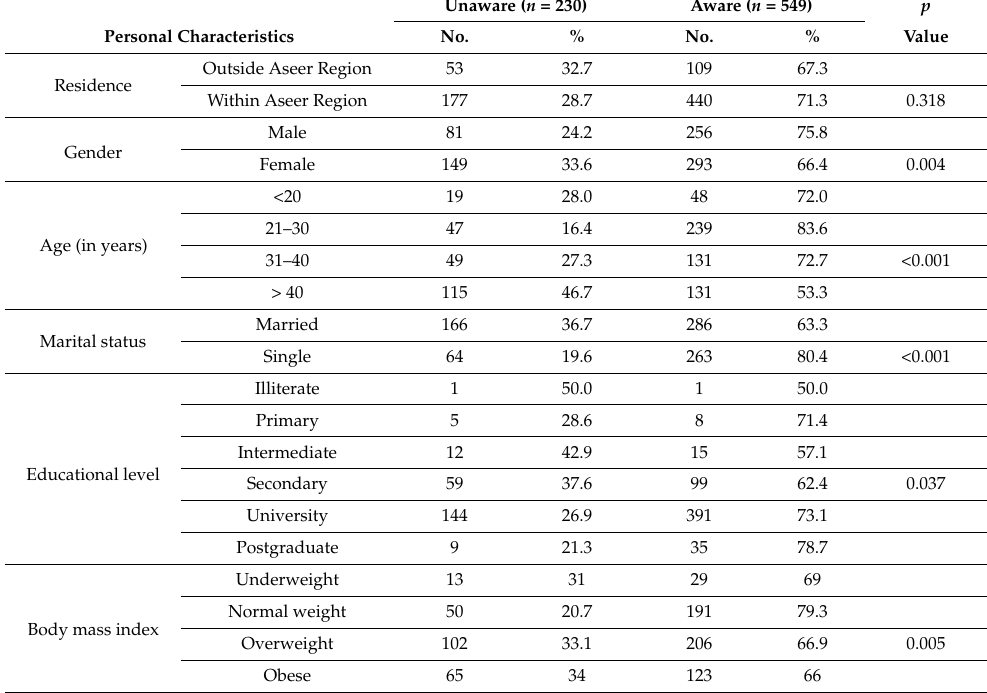
Table 3. Participants’ awareness regarding IBS according to their personal characteristics.